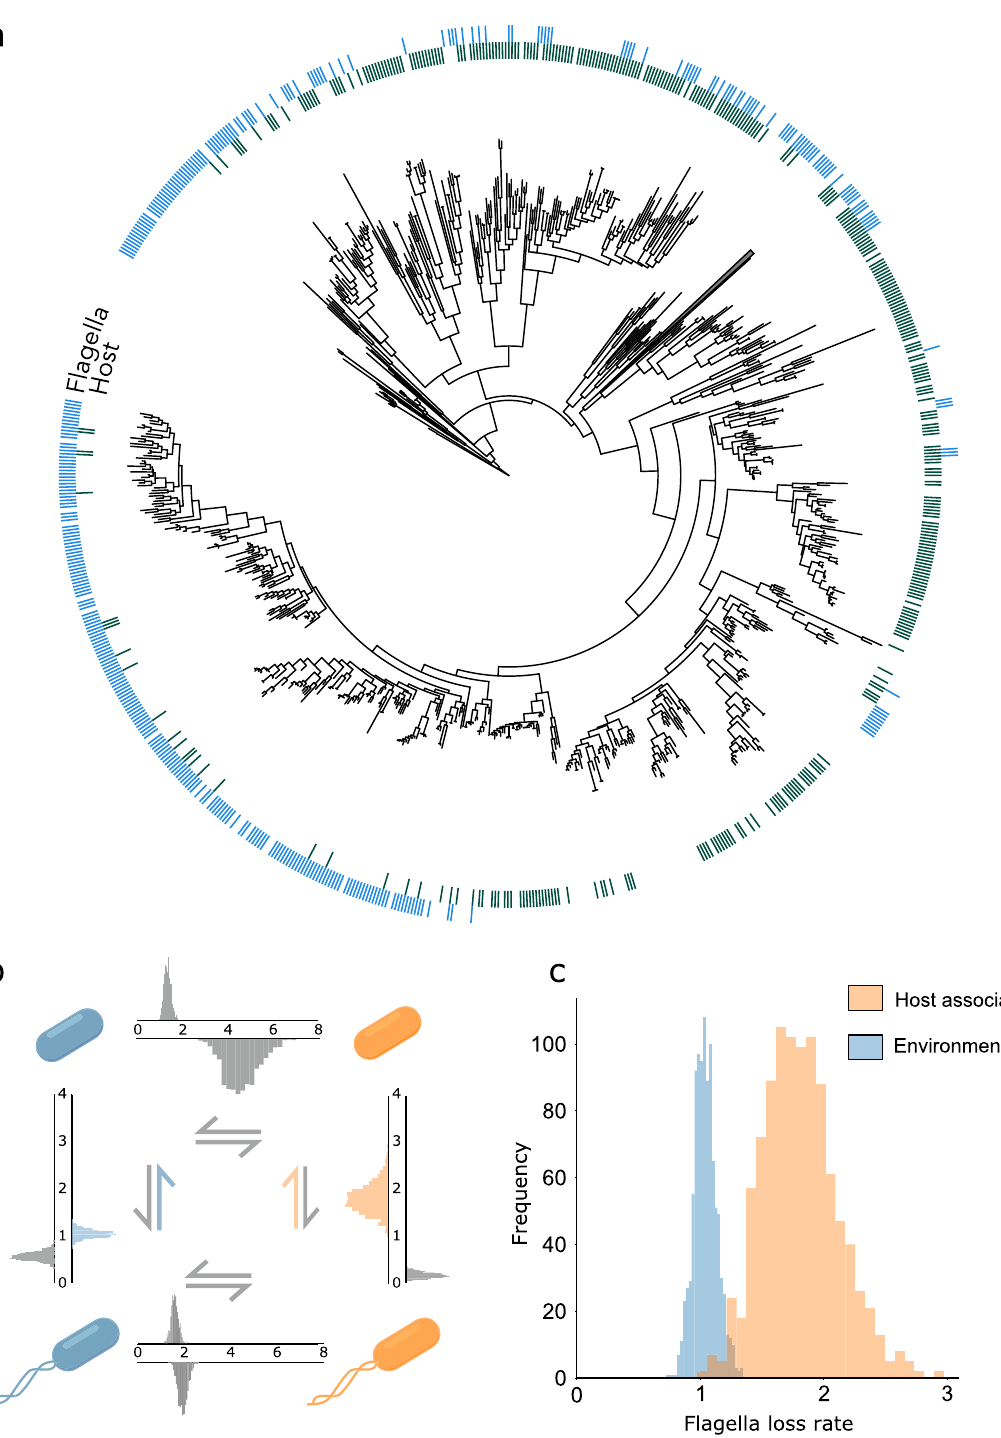
Fig. 3 Host association and possession of fl agella are negatively correlated, and host-associated bacteria have a higher rate of fl agella loss. a 16 S phylogeny for strains in the PATRIC representative dataset. We only show Firmicutes here as an example because the full phylogeny is too large to show effectively. Host association was determined using metadata from the PATRIC and BacDive databases. Flagella status was determined by identi fi ed conserved motifs of fl agellin genes. b Transitions between the four states in the data set, with and the posterior distributions of the transition rates calculated using Bayestraits 111 . c Posterior distribution of fl agella loss rates for host-associated and environmental bacteria. Our model provides evidence for a signi fi cant difference in the rate of fl agella loss between host-associated bacteria and environmental bacteria. Source data are provided as a Source Data fi le.